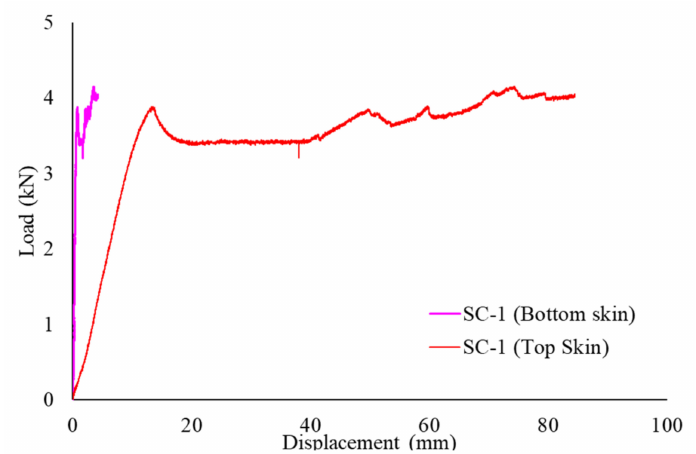
Figure 5. Load vs. displacement of top and bottom skins in SC panel. Displacement on the top skin is significantly high, whereas the bottom skin started to deflect later without any noticeable amount compared with the top skin. During the test, the displacement in the bottom skin was initiated only after the top skin touched the bottom skin. This observation is evidenced by the bottom and top skin displacement at ultimate loads as 0.91 mm and 15.30 mm, respectively (Table 2). It implies that the mid-plate contributed to distributing loads and displacements between the top and bottom